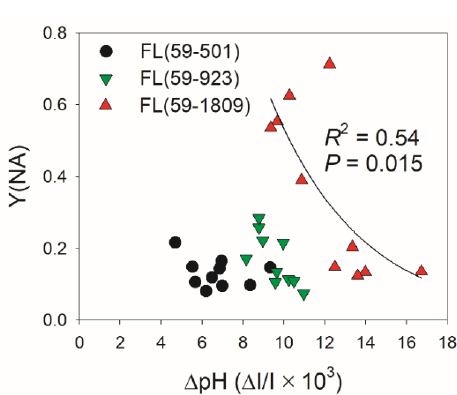
Figure A1. Relationship between Y(NA) and ∆ pH after the transition from low to high light for 10 s and 60 s different fluctuating light conditions. Each plot represents the data of an individual